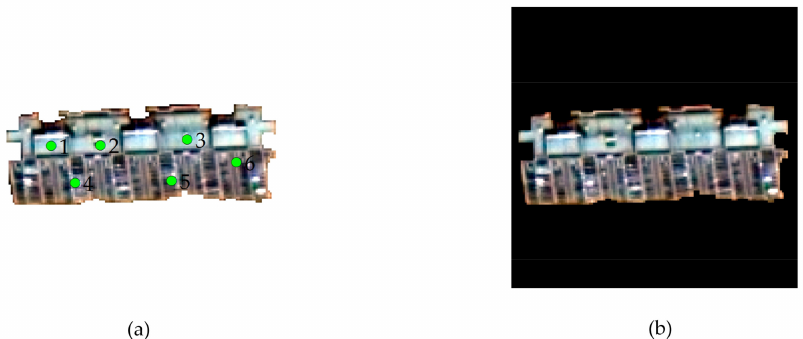
Figure 1. An example of an image object: ( a ) the original image object; ( b ) the post-processing image